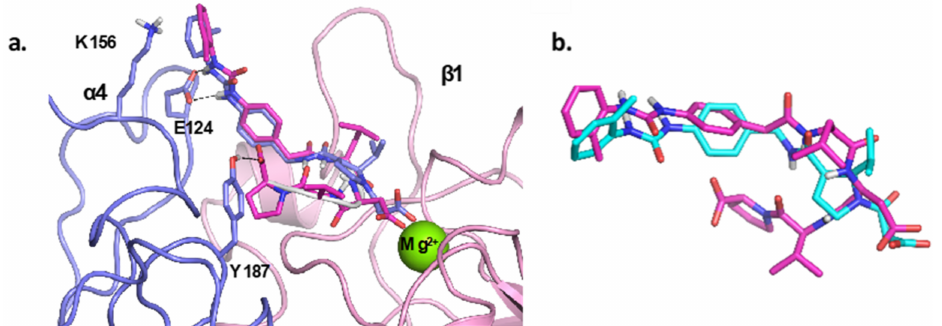
Figure 5. ( a ) Binding poses of BIO1211 (purple sticks) and 11a (blue sticks) in the binding site of α β α β 4 1 integrin ( 4 subunit blue ribbon; 1 subunit pink ribbon). The Mg green sphere. ( b ) Overlapping of compounds BIO1211 (purple sticks) and 11a (cyan sticks) obtained by docking studies.